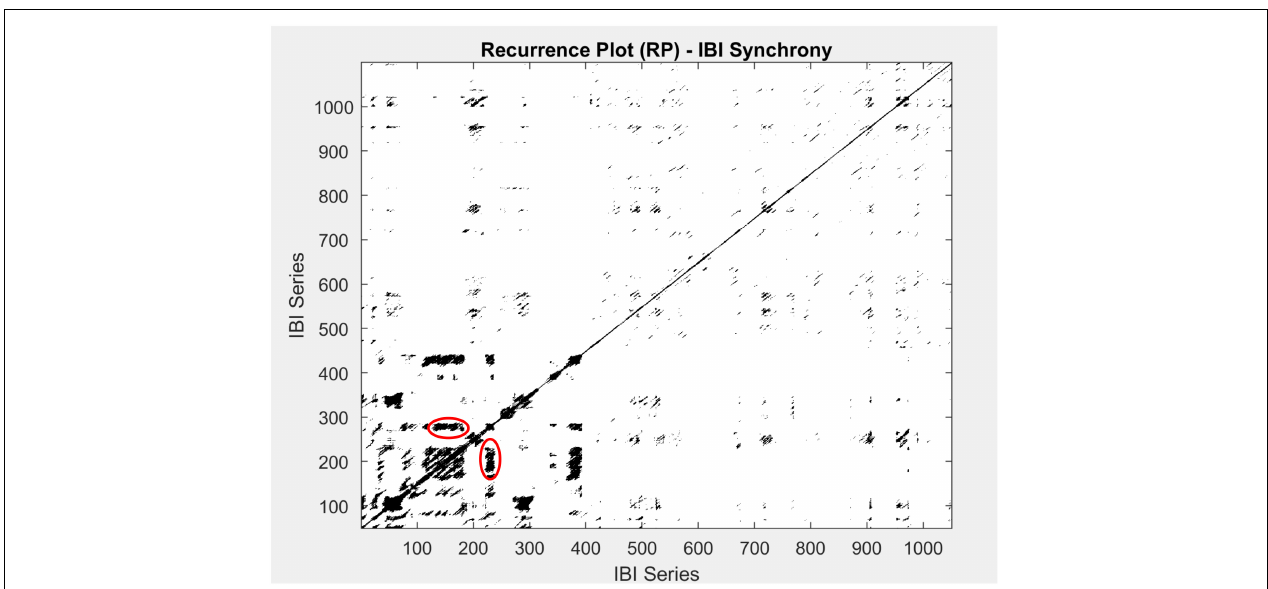
FIGURE 3 | An example of a multidimensional recurrence plot for one group participating in this study. Both the x -axis and y -axis represent the IBI time series. Blackened areas are recurrent points, and vertical lines are circled in red. To quantify the recurrence rate (REC%), we calculate the percentage of recurrent points across the matrix. Further, to identify recurrence patterns in time, we use LAM%, the rate of recurrence points with a vertical neighbor, and the length of the vertical lines (meanV and maxV).